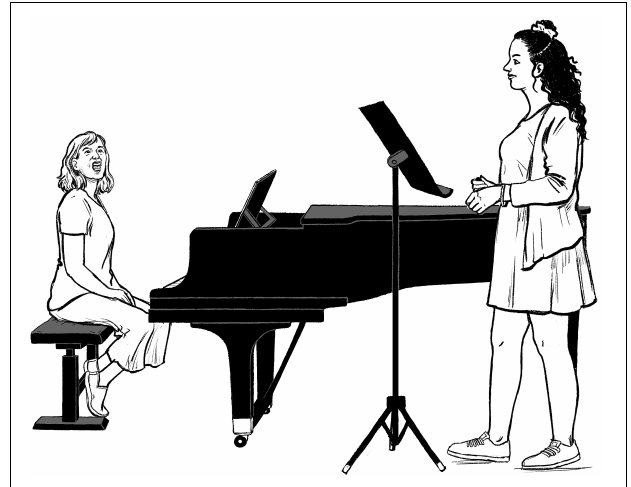
FIGURE 7 | Teacher dramatizing the text with facial